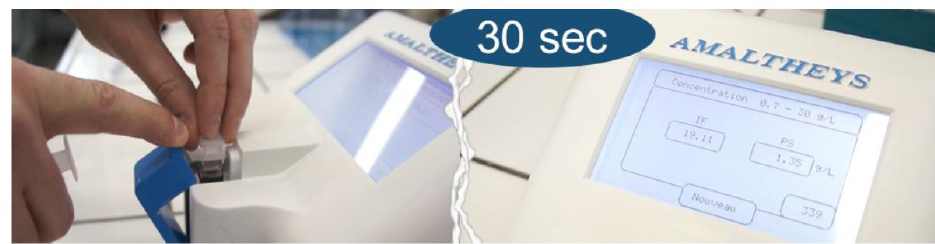
Figure 6. Amaltheys ® device.